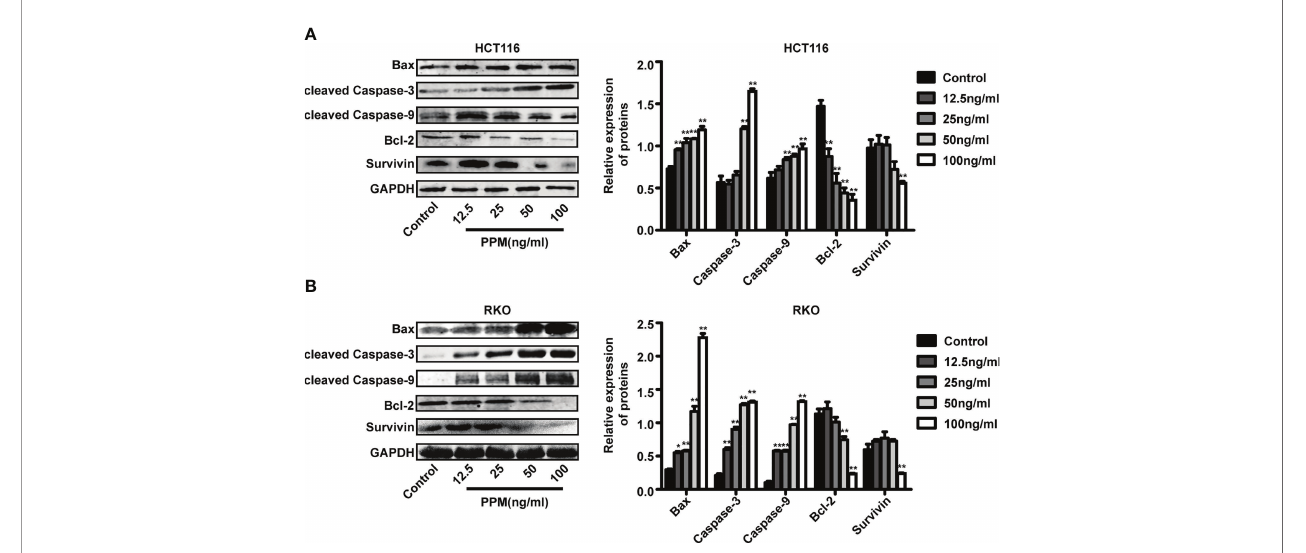
FIGURE 3 | Periplocymarin (PPM) altered gene expression involved in apoptosis. Western blot analysis of Bax, Bcl-2, cleaved caspase-3, cleaved caspase-9, and survivin protein levels in HCT 116 (A) and RKO cells (B) treated with different concentrations of PPM (0, 12.5, 25, 50, or 100 ng/ml) for 24 h. Values are shown as means ± SEM. * P < 0.05, ** P < 0.01, vs . untreated control